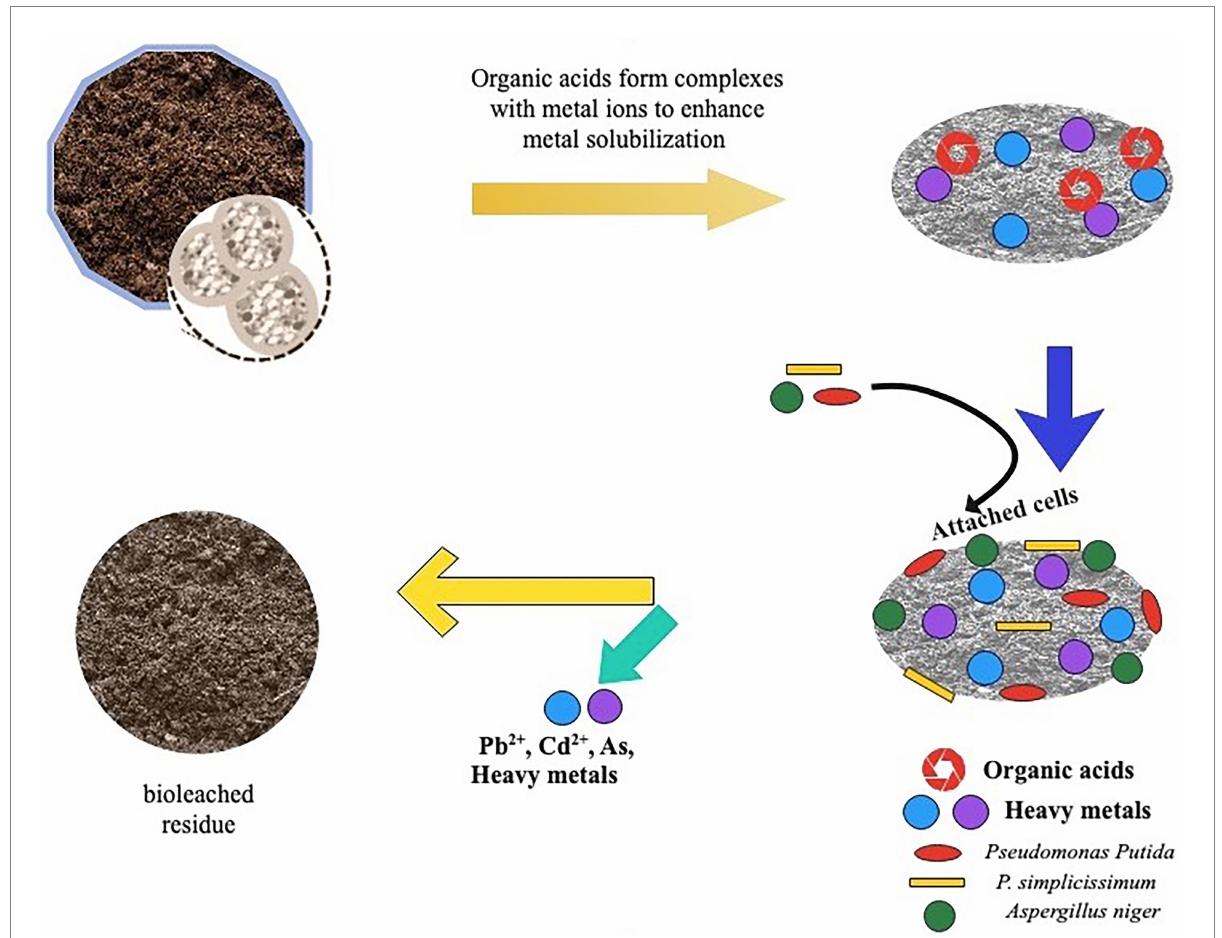
FIGURE 2 Schematic diagram of toxic metal(loid)s solubilization in contaminated soil by organic acids. Organic acids produced by bacteria facilitate solubilization by supplying protons and metal complexing organic acids anions. This results in ion exchange, proton -promoted mechanism releasing toxic metal (loid)s from contaminated